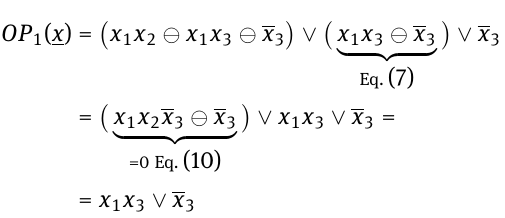
Example 3: Now, the sorted function sort dSOP 1 ( x ) = x 1 x 2 ∨ x 1 x 3 ∨ x 3 of Example 2 has to be orthogonalized by Eq. (11).